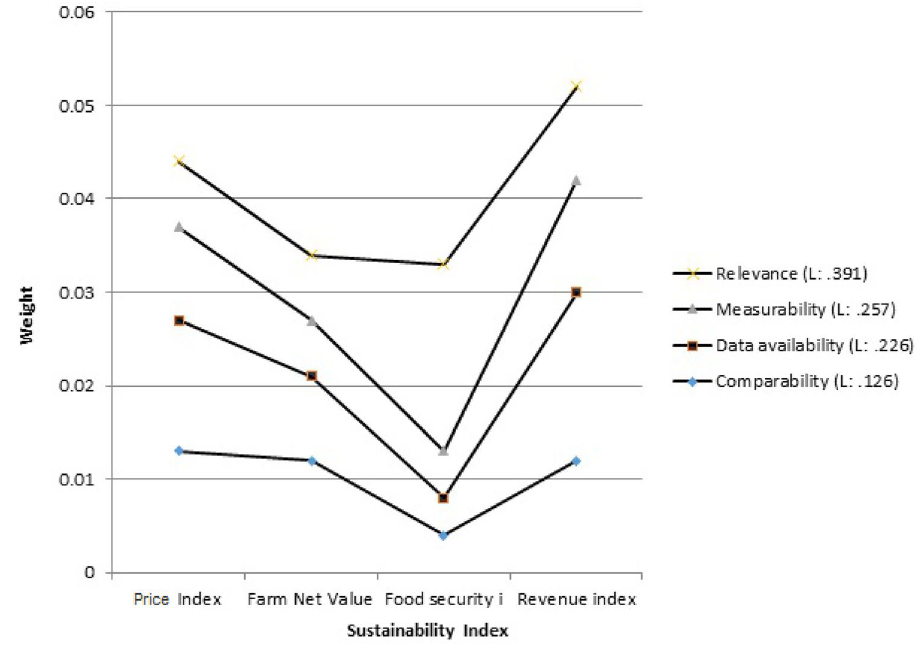
Figure 7. Food sustainability